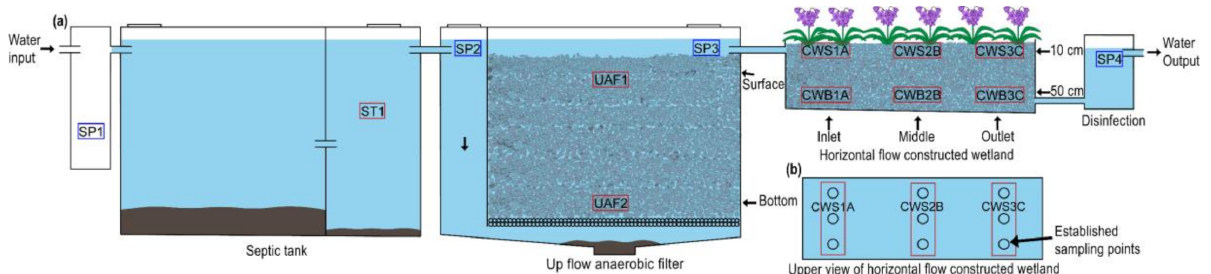
Figure 2. Diagram of sampling points for sequencing and water quality analysis where ( a ) represents a lateral view of the WWTP, sampling points for sequencing analysis are indicated by red boxes and sampling points for water quality analysis (SP1, SP2, SP3, and SP4) are indicated by blue boxes; ( b ) represents an aerial view of the HFCW, individual samples used in the preparation of the composite samples are grouped in red